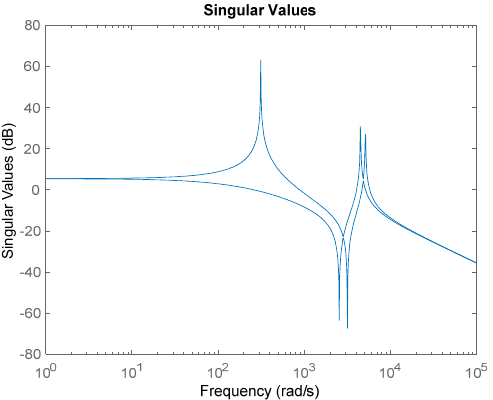
Figure 7. Frequency characteristics of the closed loop system.